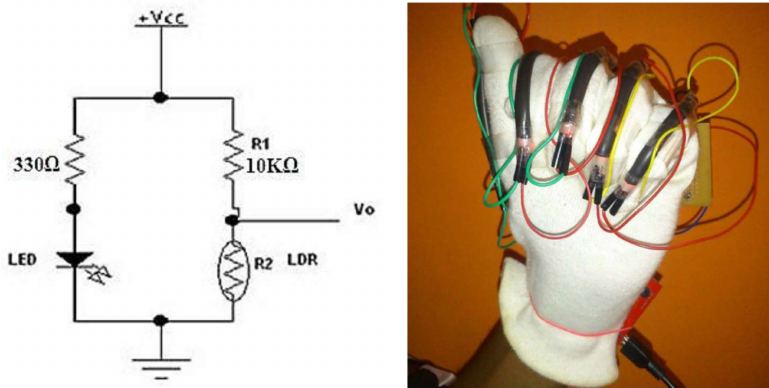
Figure 7. A circuit diagram of LED-LDR and the sensors’ positions on the glove [37].